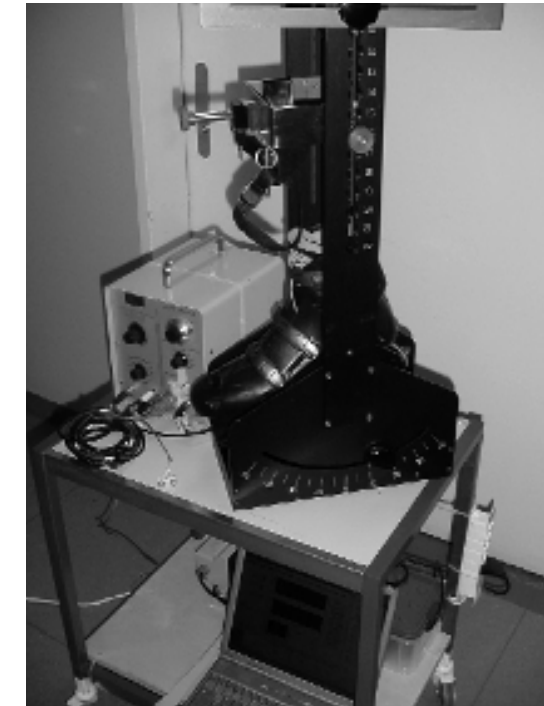
Muscle force assess- ment system to de- termine isometric torque in humans [5–9]. The system has four main com- ponents: (i) A stabil- ising device consist- ing of two metal bars, straps and a boot. The boot is fixed on a foot plate that can be rotated and fixed at any posi- tion between –40° to 40°; (ii) A strain gauge system with a Wheatstone bridge circuit that detects the evoked torque produced by the stimulated ankle dor- siflexor group; (iii) A stimulator/ampli- fier unit that can sup- ply variable stimulus pulse amplitudes and pulse durations and can amplify the volt- age changes evoked by the torque of the stimulated muscle; (iv) A computer with data acquisition soft- ware for simultane- ously recording, analysing, and dis- playing all